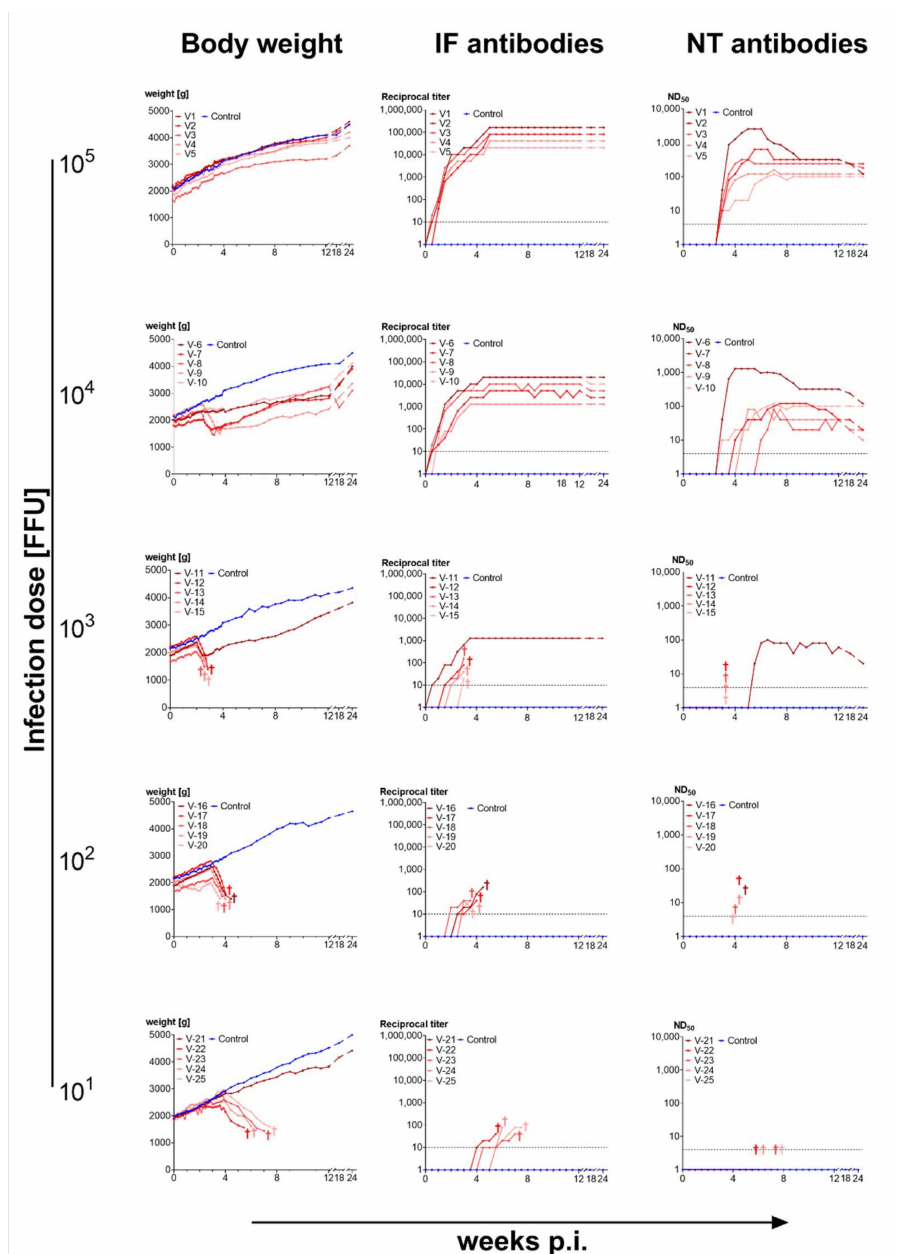
Figure 4. Titration of infectious dose of OL-cell-culture-derived BoDV-1 (virus V/B) in rabbits. Shown are the kinetics of body weights, immunofluorescent (IF) antibodies and neutralizing (NT) antibodies following infection challenge with 10 5 FFU OL-derived BoDV-1, 10 4 FFU OL-derived BoDV-1, 10 3 FFU OL-derived BoDV-1, 10 2 FFU OL-derived BoDV-1, and 10 1 FFU OL-derived BoDV-1. Dashed lines, IF and NT assay limits of detection; †, animal euthanized before succumbing to lethal illness. Brain samples of the rabbits that succumbed to disease had strong RT-PCR viral signals, whereas brain samples of surviving rabbits euthanized at the end of the trial were PCR- negative for BoDV-1. In the five rabbits investigated for the presence of virus after high-dose infection (trial IV), positive signals by RT-PCR BoDV-1-were only found 1–3 weeks p.i. in the frontal cortex (near injection site) but not in other regions of the brain and not in organs outside the CNS (heart, liver, spleen, kidney, bladder,